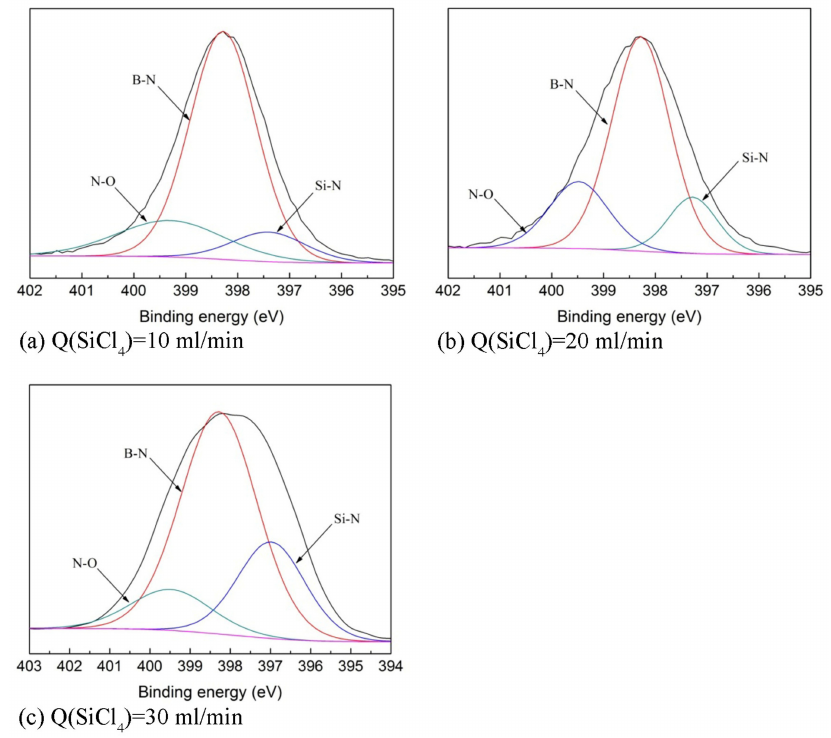
Figure 5. N1s spectra of SiBN ceramic deposited at various SiCl 4 flow rates ( a ) Q(SiCl 4 ) = 10 mL/min;